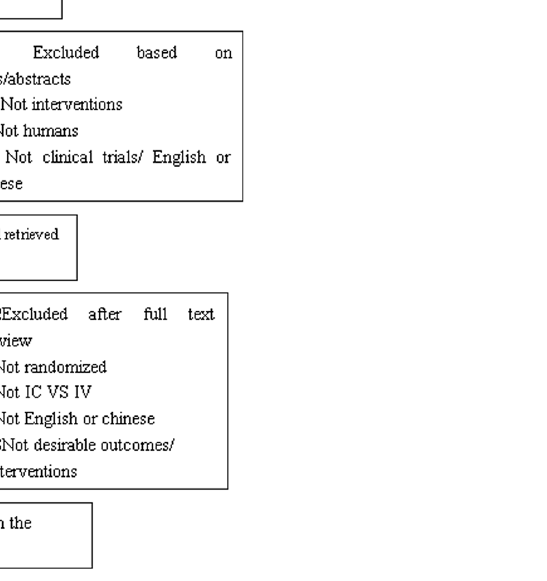
Fig 2. Study selection